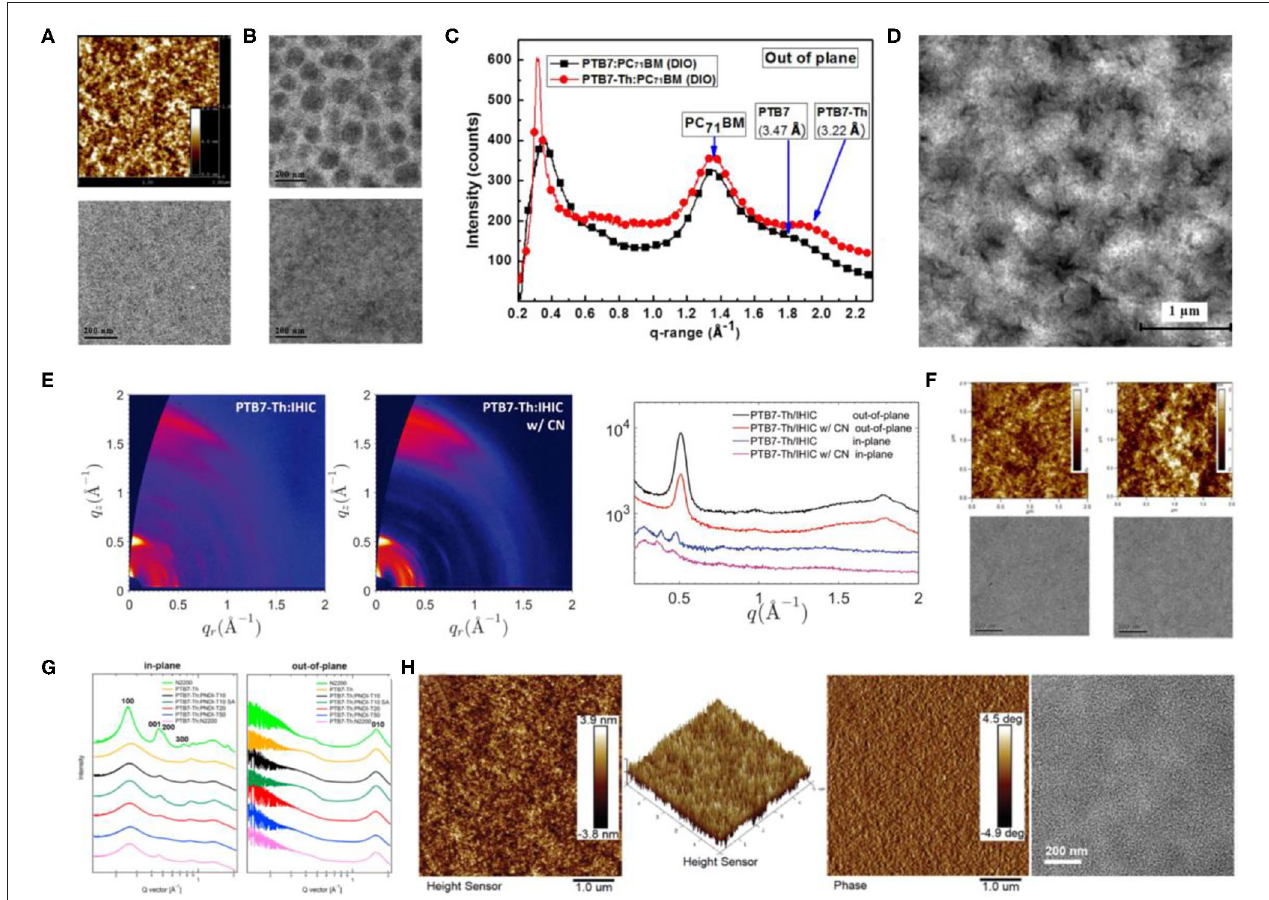
FIGURE 6 | (A) AFM topography image (top) and TEM image (bottom) of PTB1/PC61BM blend films. Copyright 2009, American Chemical Society. (B) TEM images of PTB7/PC71BM blend film prepared from CB without (top) and with (bottom) DIO (the scale bar is 200nm). Copyright 2010, Wiley-VCH. (C) Out-of-plane line cut of GIWAXS with PTB7:PC71BM and PTB7-Th:PC71BM (1:1.5 wt/wt, 100nm). Copyright 2013, Wiley-VCH. (D) TEM image of PTB7-TH:ITIC (1:1.3, wt/wt) blended film. Copyright 2015, Wiley-VCH. (E) 2D GIWAXS patterns (left) of PTB7-Th:IHIC with and without 1-chloronaphthalene (CN) and the corresponding GIWAXS profiles (right) along the out-of-plane and in-plane directions. Copyright 2017, Wiley-VCH. (F) AFM (top) and TEM images (bottom) of TPB/PTB7-Th films (left) without additive and (right) 8% diphenyl ether (DPE) as additive. Copyright 2016, American Chemical Society. (G) In-plane and out-of-plane line cuts of GIWAXS patterns of PTB7-Th:PNDI-Tx and PTB7-Th:N2200 blend films. Copyright 2016, American Chemical Society. (H) AFM height image, 2D height image, phase image, and TEM images (from left to right) of optimal PBFTT:IT-4Cl blend films. Copyright 2019, Reproduced with